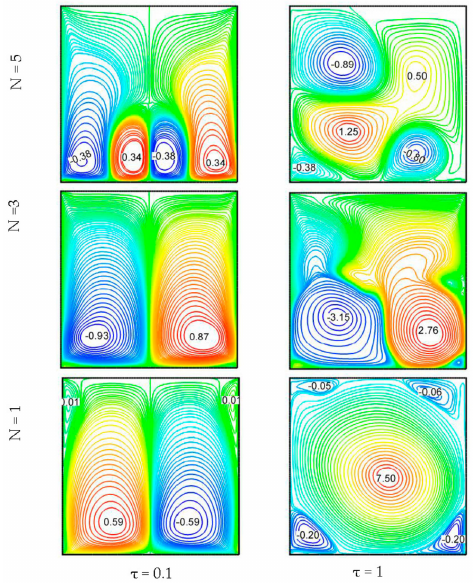
Figure 7. Influence of the odd values of N on streamlines for the selected values of τ with Gr = 10 7 .